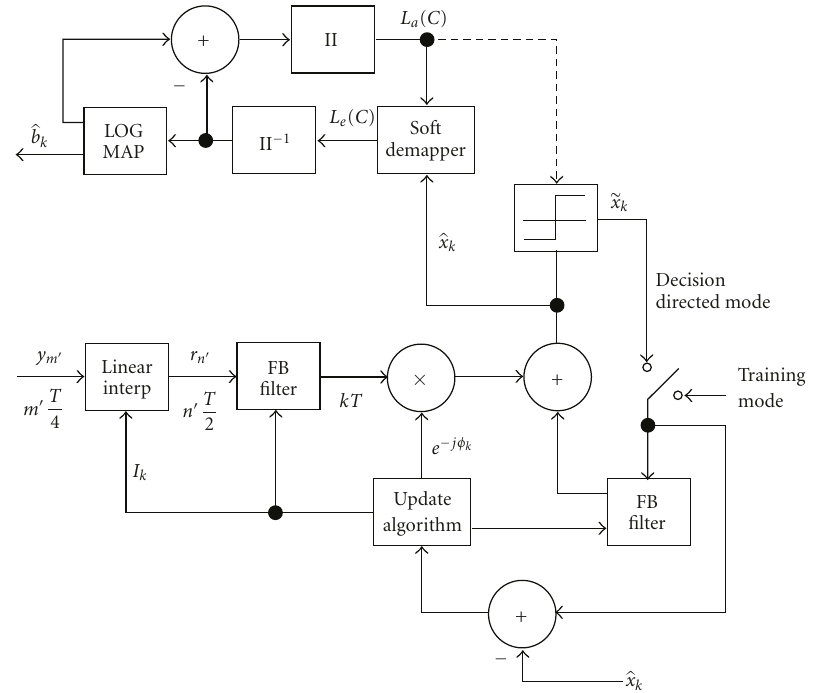
Figure 3: Proposed receiver